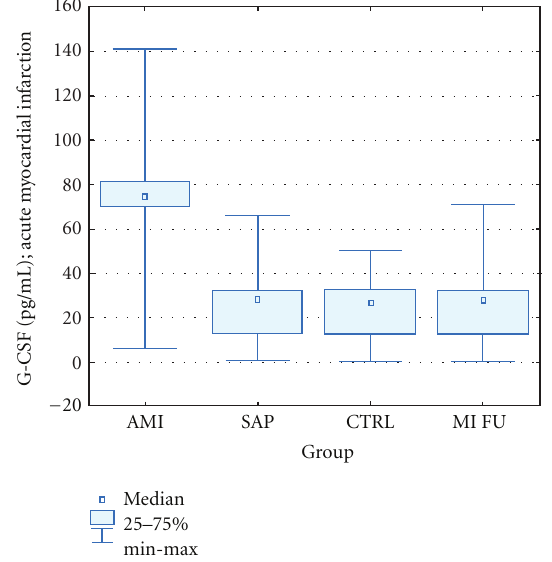
Figure 3: Plasma G-CSF levels. AMI: acute myocardial infarction, SAP: stable angina pectoris, CTRL: control group, MI FU: 1-year followup. Data is presented as cell number in 1 μ L of peripheral blood (median ±